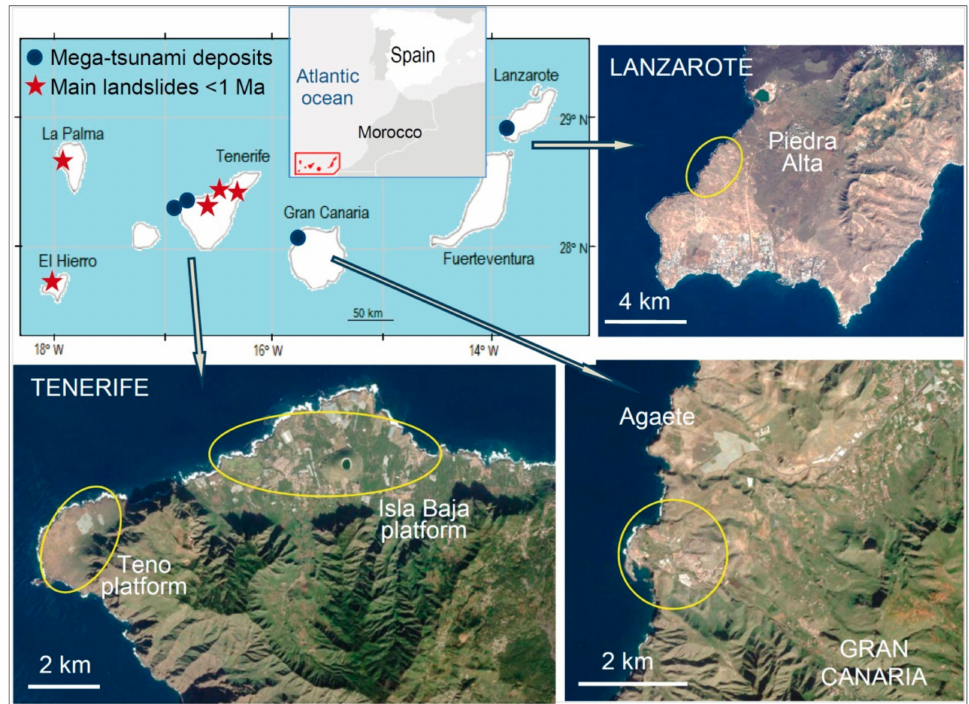
Figure 1. Location of the tsunami deposits and main recent (<1 Ma) megalandslides in Canary Islands. Satellite images with the location of the tsunami deposits at Teno and Isla Baja platforms, Tenerife; Piedra Alta, Lanzarote; and Agaete, Gran Canaria. Google Earth